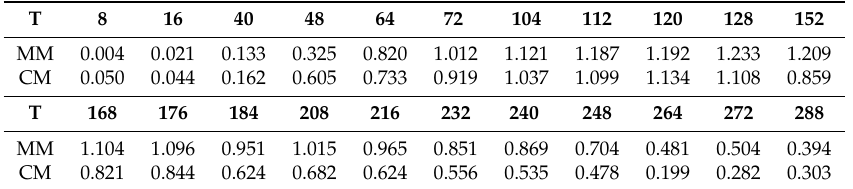
Table A2. Datasets used to fit diatom growth in minimal and complete media (MM and CM respectively). Time is scaled (1/3 of a day) to fit reasonably the growth phases (lag-log-exp-decay) using parameters O ( 1 ) . For the same reason cell counts are scaled to bring the lower count close to 0, but not feature-scaled to avoid loosing information on differences among MM and CM conditions. Only average values, and not experimental errors, are taken into account.